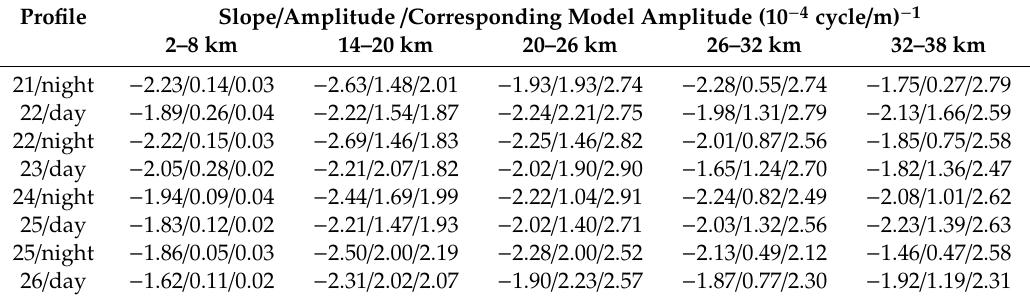
Table 1. Spectrum slope and amplitude of normalized temperature